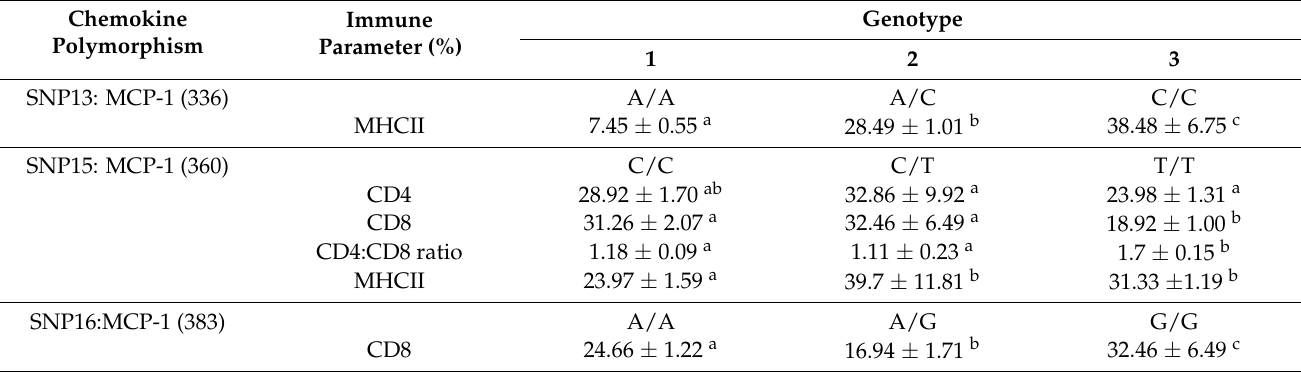
Table 5. Effects of SNPs in chemokine genes on the expression of immunity parameters in pig lymphocytes. Chemokine